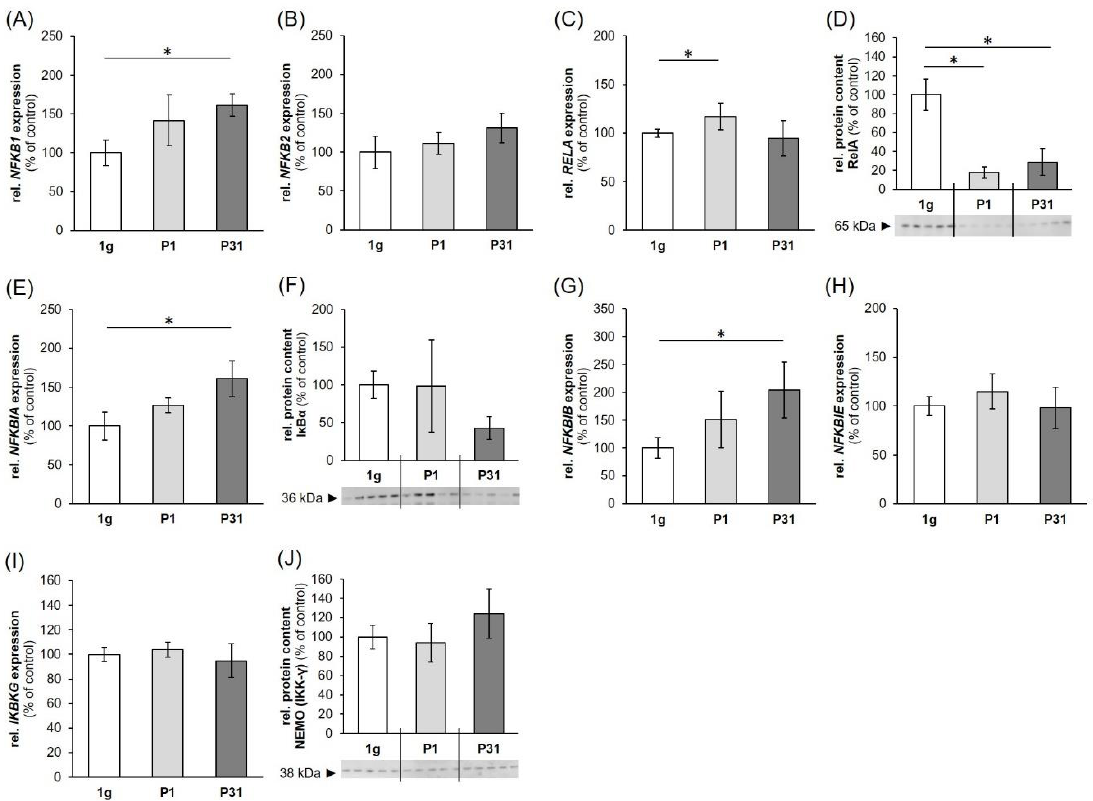
Figure 2. Influence of short-term microgravity on the gene expression: ( A ) NFKB1 , ( B ) NFKB2 , ( C ) RELA , ( E ) NFKBIA , ( G ) NFKBIB , ( H ) NFKBIE , ( I ) IKBKG and protein content: ( D ) RelA, ( F ) IκBα ( J ) NEMO; of NF-κB signaling factors. n = 5; The data are given as mean ± standard deviation. * p < 0.05 vs. 1 g-control .